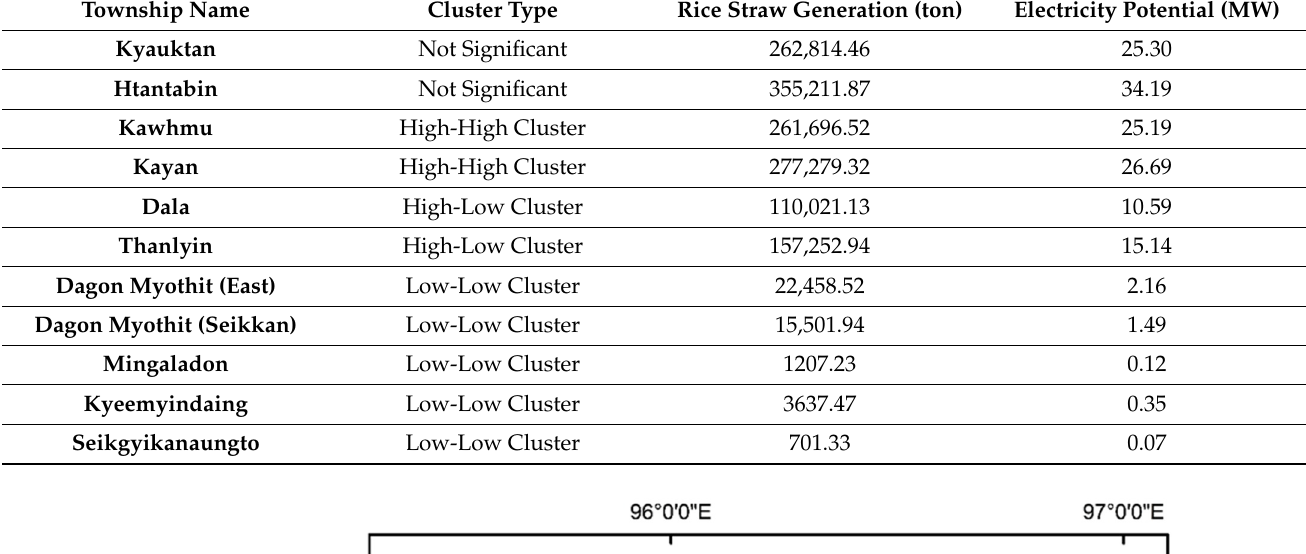
Figure 5. The result of Incremental Spatial Autocorrelations.